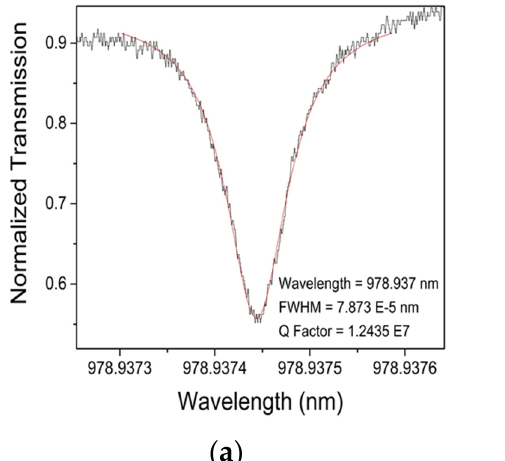
( b ) Figure 10. Images were taken from Dish 23 Sphere 3. Visible difference in the fluorescence intensity between two phases. ( a ) Pre-extraction; ( b ) Post-extraction. This particular image showed 59% loss in the intensity value after the extraction. The average intensity loss for this data set was calculated as 58%.